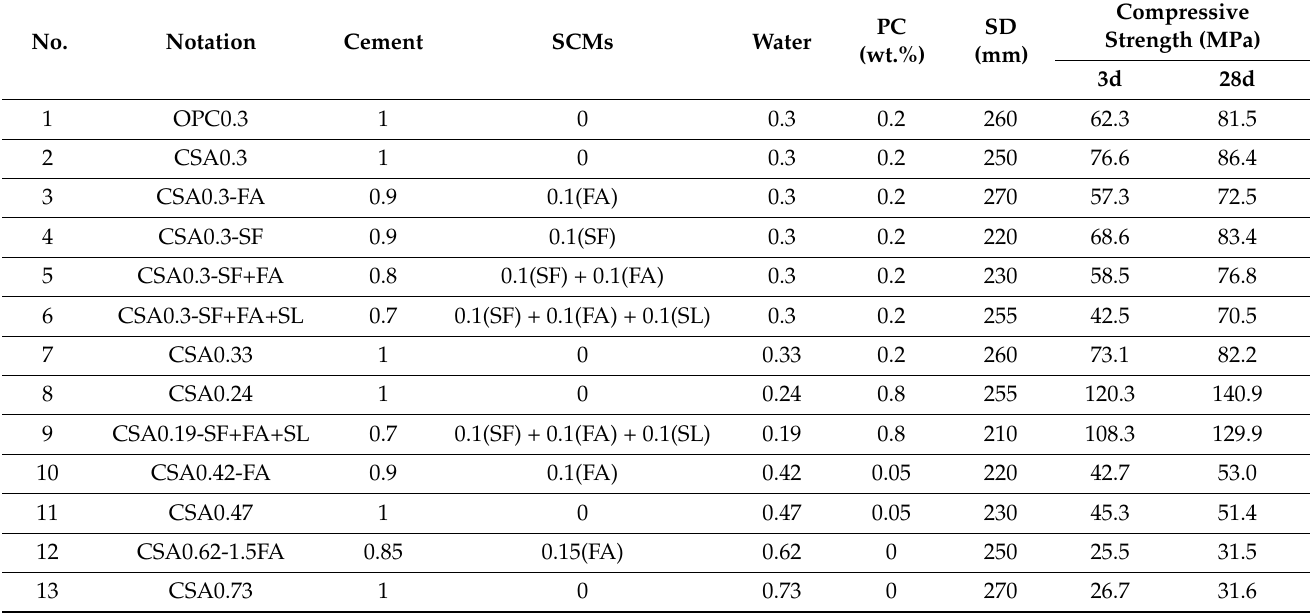
Table 2. Mixture proportion, fluidity, and compressive strength of the cement